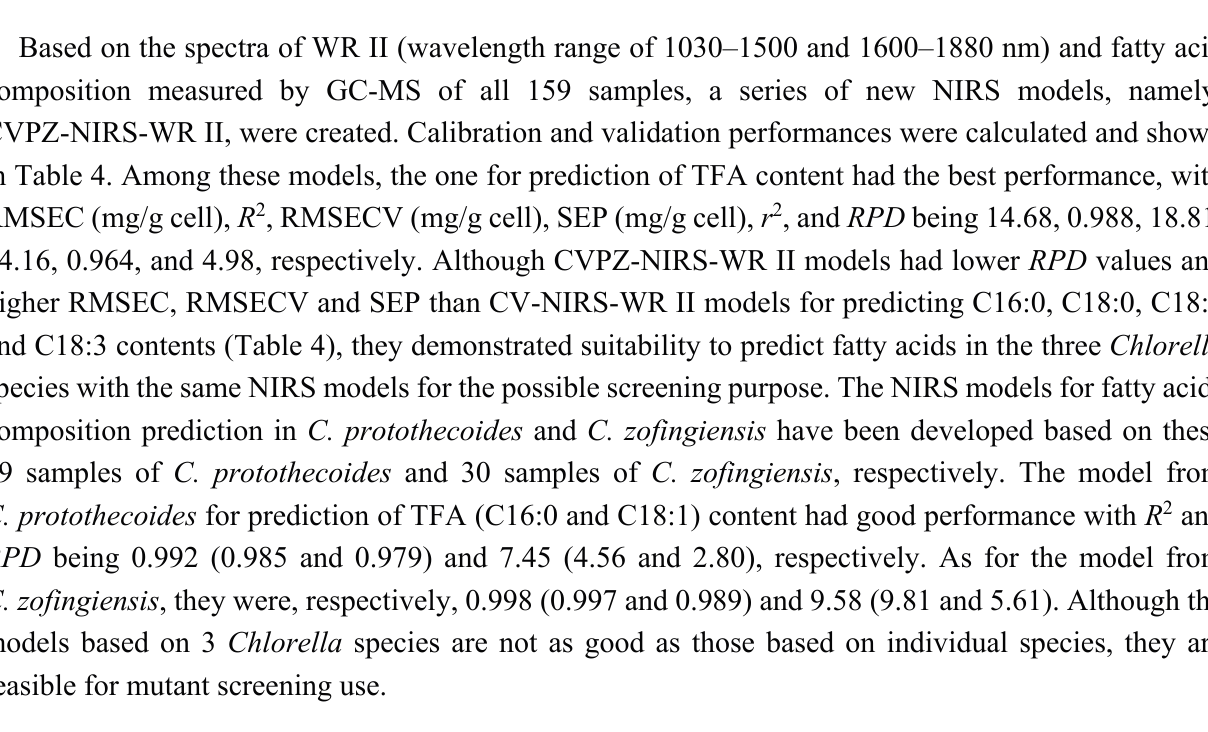
Table 4. PLS 1 analysis result for CVPZ-NIRS-WR II models.